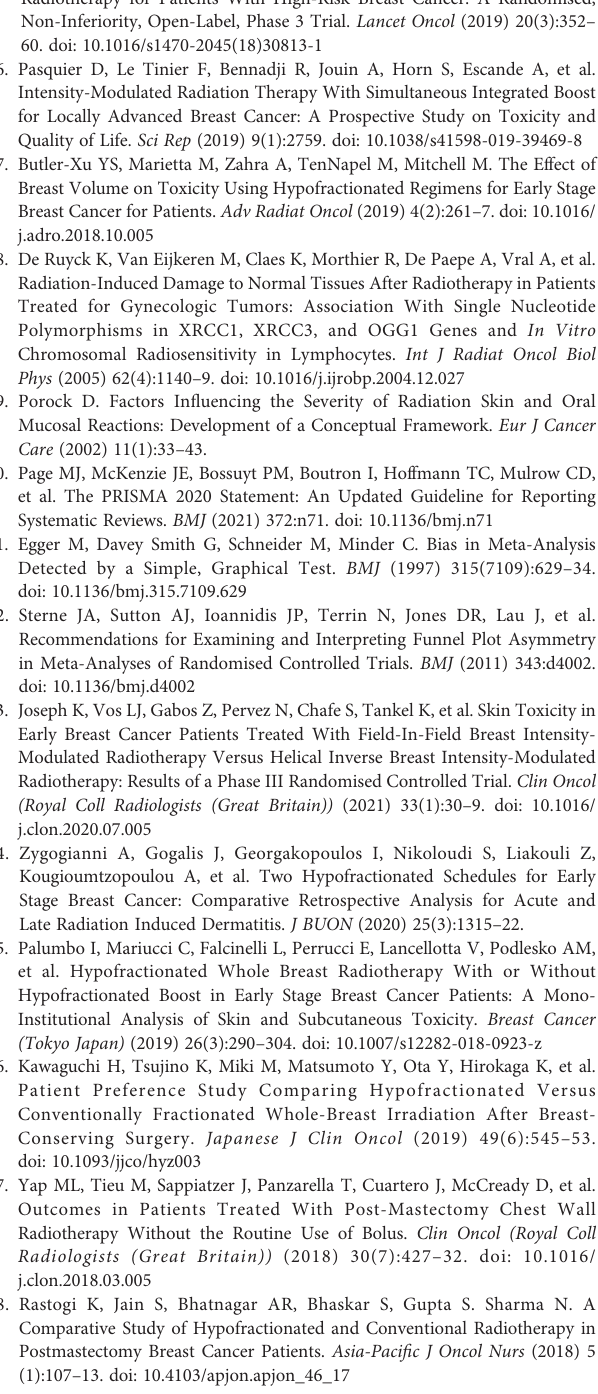
Supplementary Table 3 | CommonTerminologyCriteriaforAdverseEvents(CTCAE)or TheRadiationTherapyOncologyGroup(RTOG)toxicityscalesforacuteradiationdermatitis. Supplementary Table 4 | Quality assessment of eligible studies by Newcastle- Ottawa Scale (NOS). Supplementary Table 5 | Results of individual studies: summary statistics for each group and an effect